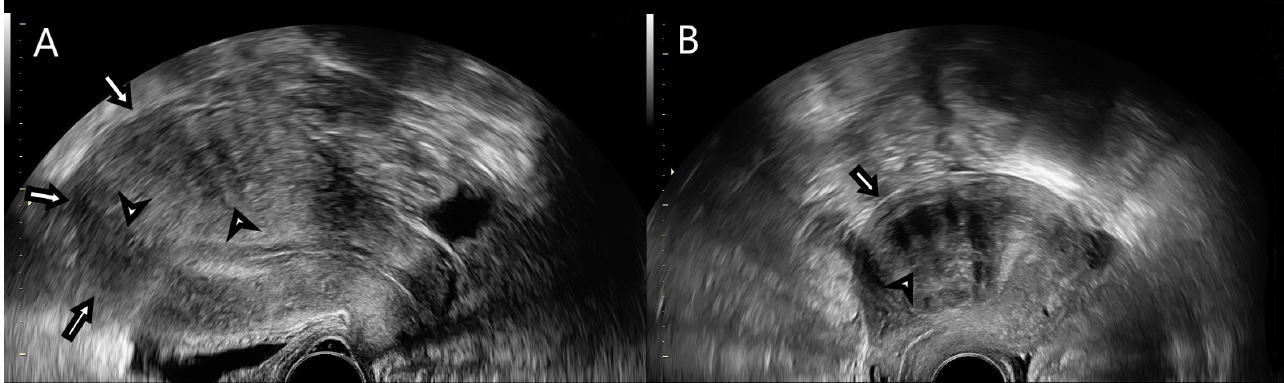
Figure 1. ( A ) B-mode transvaginal ultrasound features of uterine adenomyosis (highlighted by the arrows): enlarged globular uterus, fan-shaped shadowing and myometrial cysts. ( B ) B-mode transvaginal ultrasound features of uterine fibroids (highlighted by the arrows): well-defined round lesion within the myometrium with inner fan-shaped shadowing.